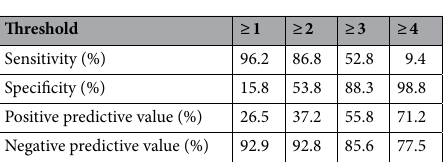
Table 3. Simplified score for predicting hypoxemia in patients with type-B acute aortic syndrome.